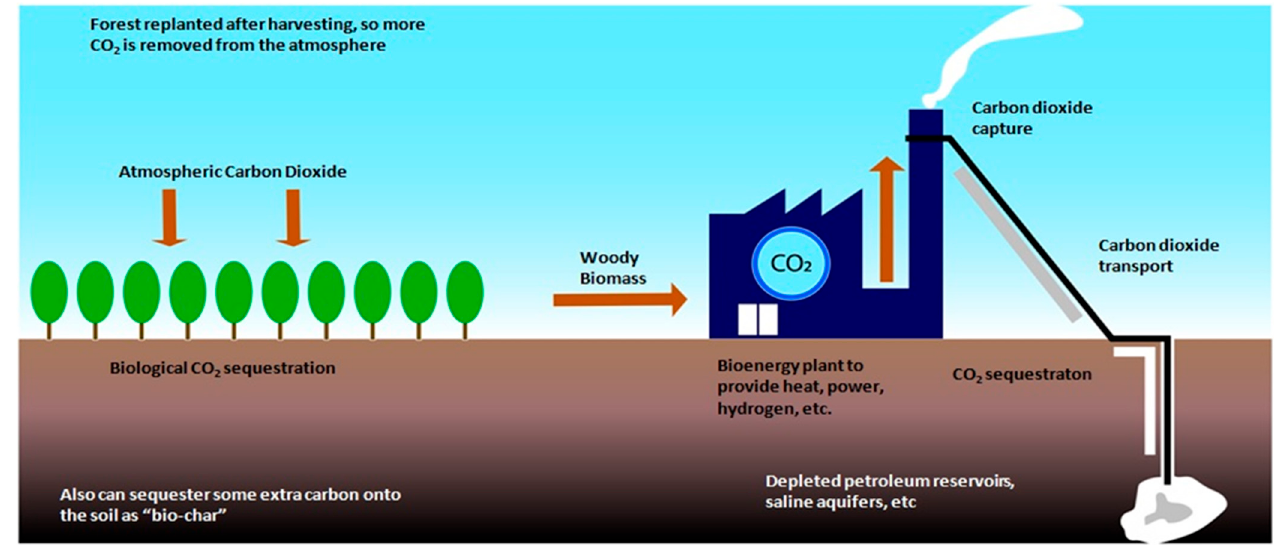
Figure 2. Bioenergy with carbon capture and storage (BECCS) process.